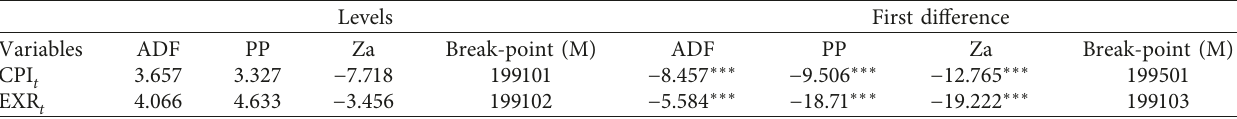
Table 2: Results of unit root and break-points.